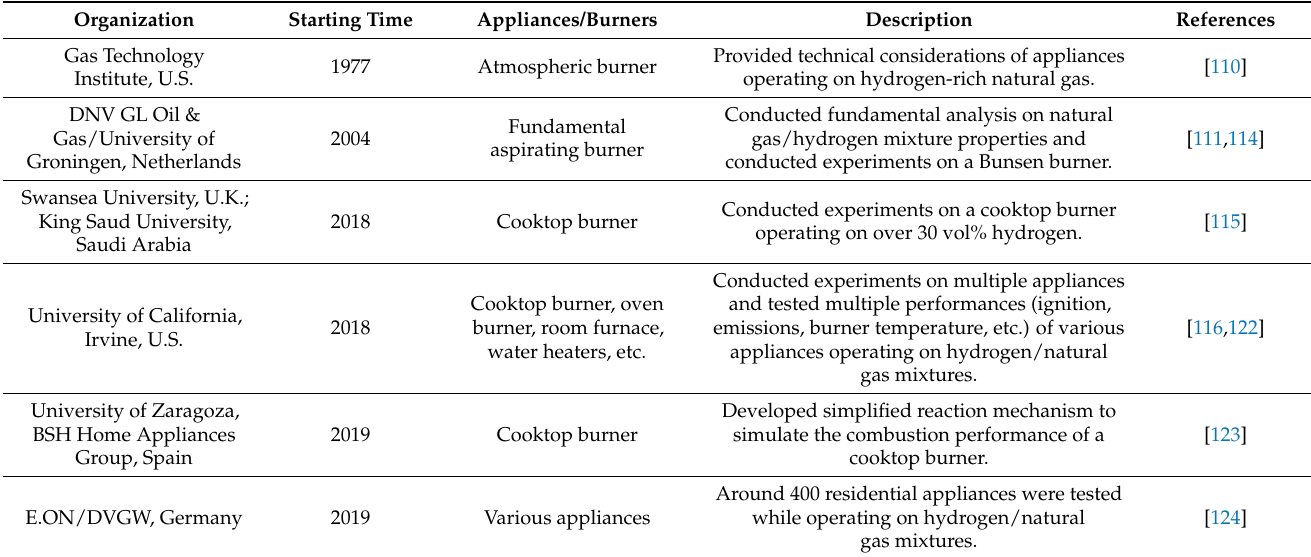
Table 9. Tests on residential appliances operating on hydrogen-enriched natural